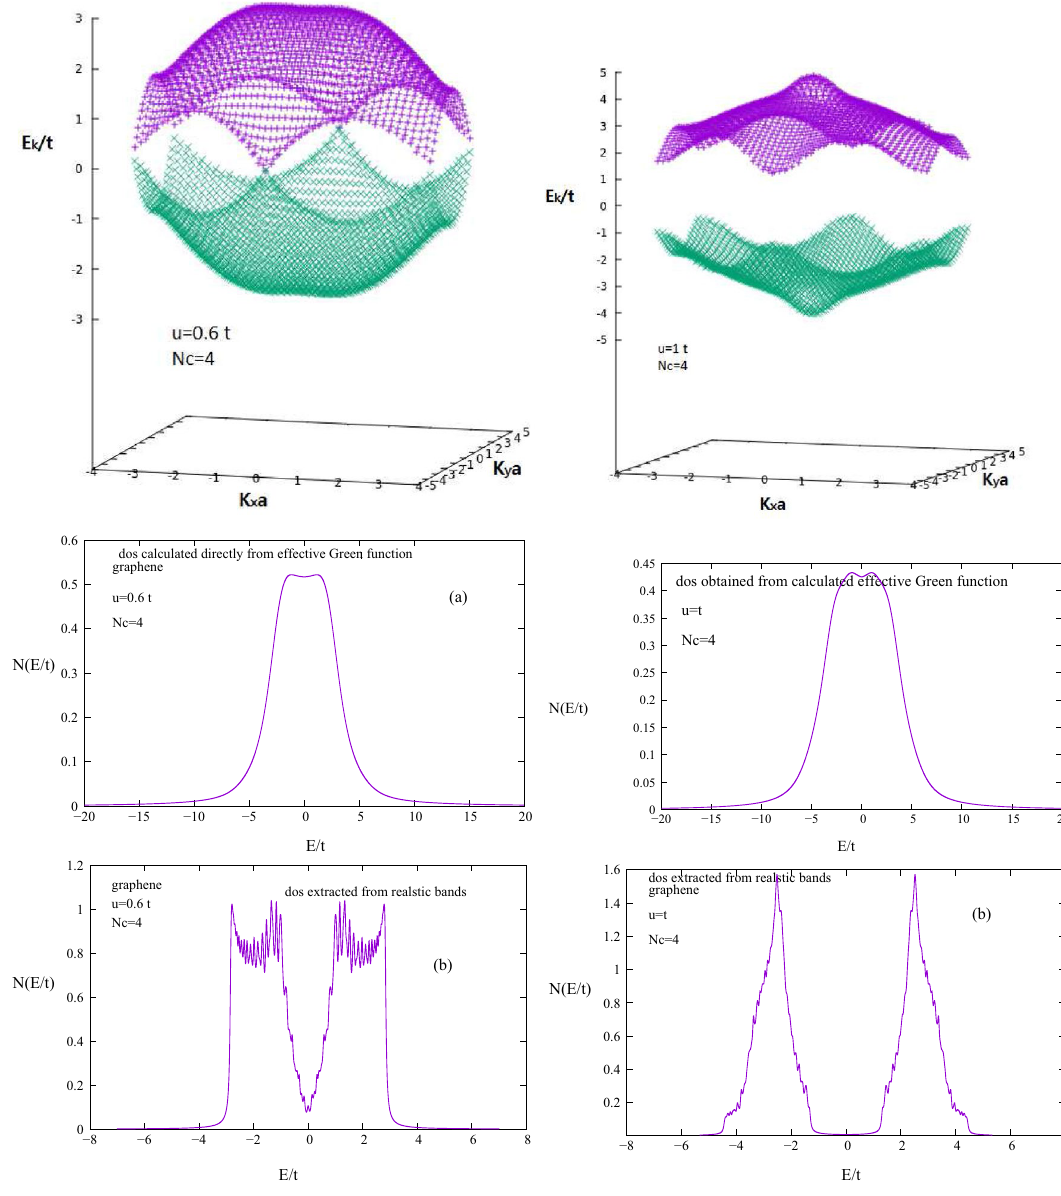
4 calculated realistic bands for repulsion energy =